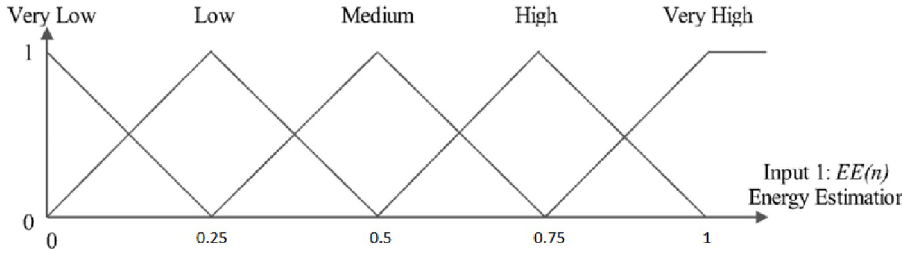
Fig 4. Graph of node energy estimation.